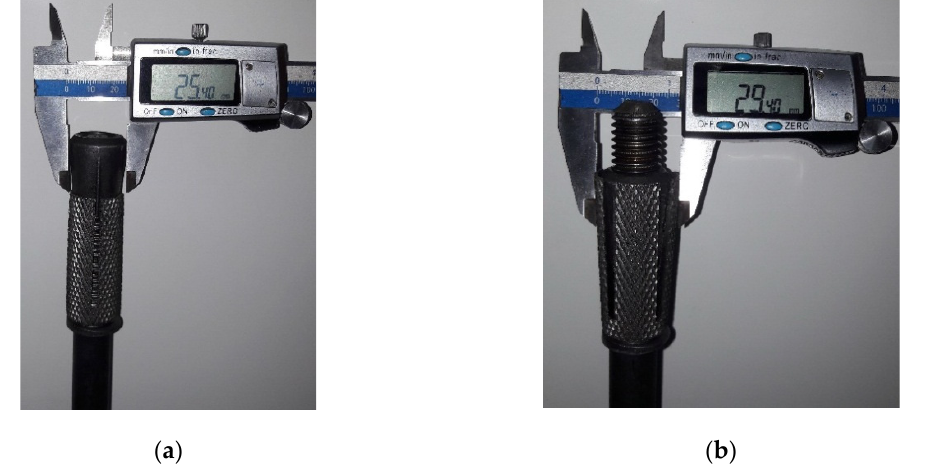
Figure7. Mechanicalsleeveheadscrewedontheboltrod: ( a )beforespreading; ( b Figure 7. Mechanical sleeve head screwed on the bolt rod: ( a ) before spreading; ( b ) at maximal spreading .